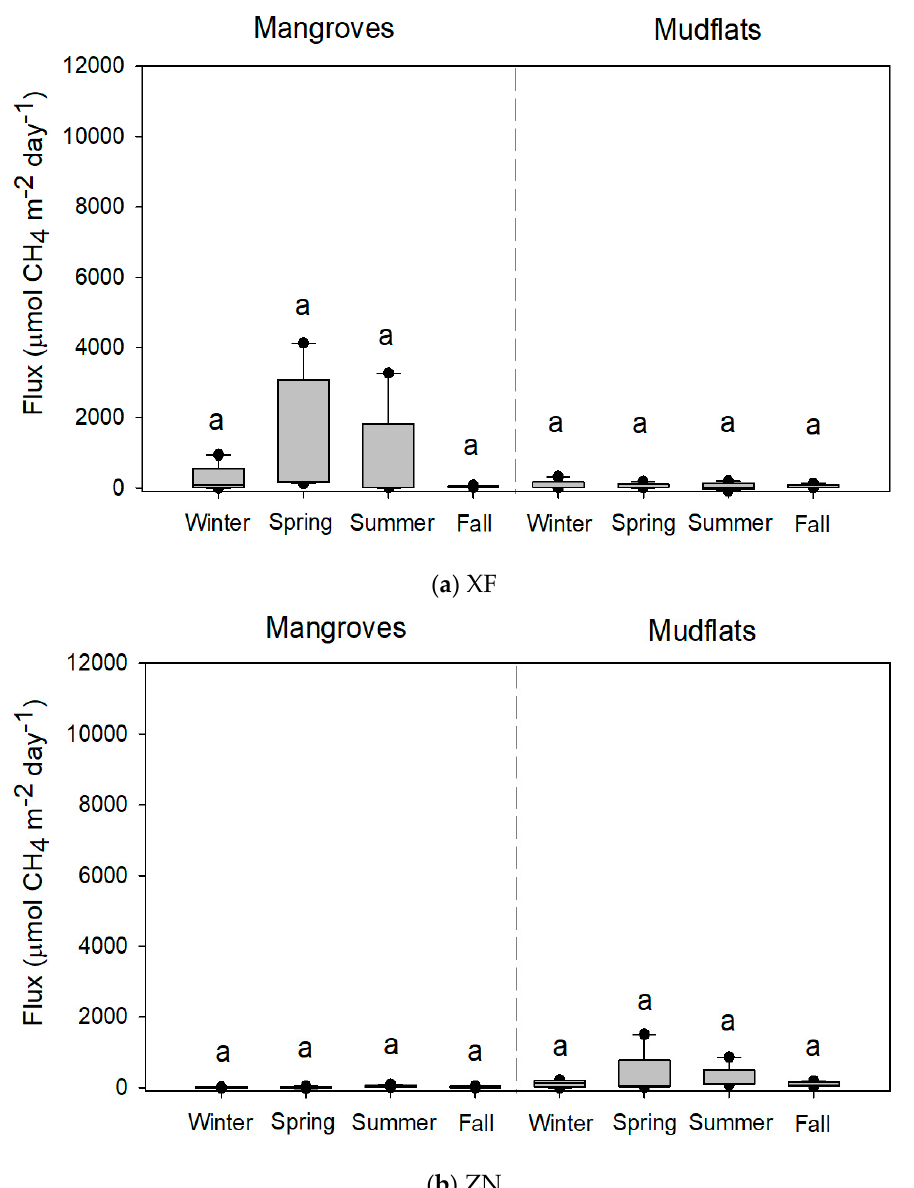
Figure 2. Methane fluxes ( n = 5) from the soils of mangroves of Kandelia obovata and adjoining mudflats at ( a ) Xinfeng (XF) and ( b ) Zhunan (ZN). Same letters indicate no significant seasonal differences with the Kruskal–Wallis test and Tukey’s honestly significant difference (HSD) test and the Bonferroni correction for the significance level in mangroves and mudflats, respectively.